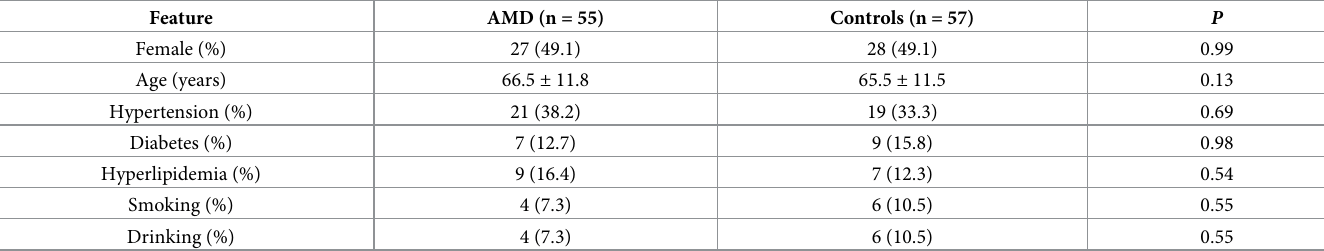
Table 2. Demographic and clinical features of patients with AMD and controls.